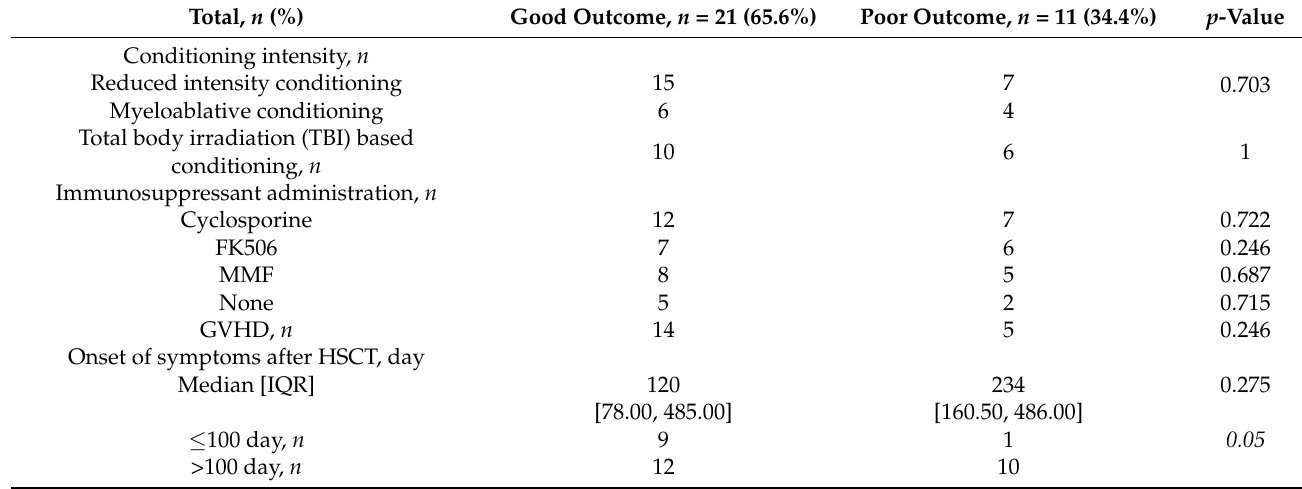
Table 4. Neurological outcome assessments in patients with neurological symptom onset after HSCT. Total, n